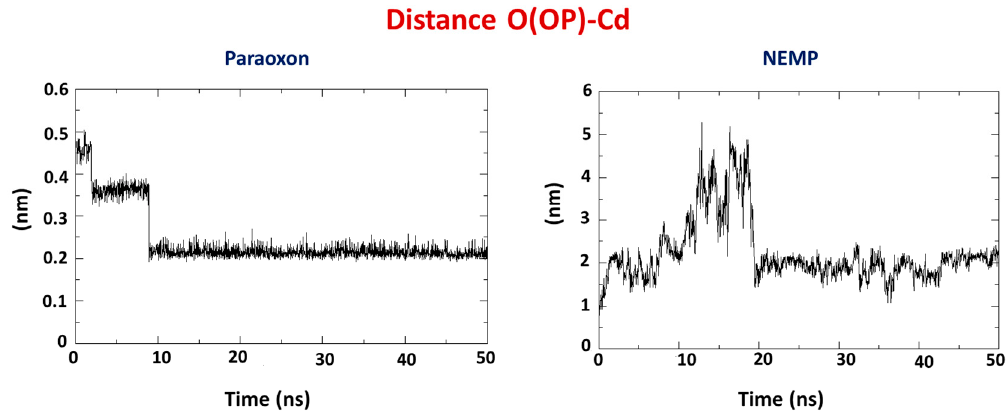
Figure 10. Average interatomic distance O(OP)-Cd for PXN and NEMP.